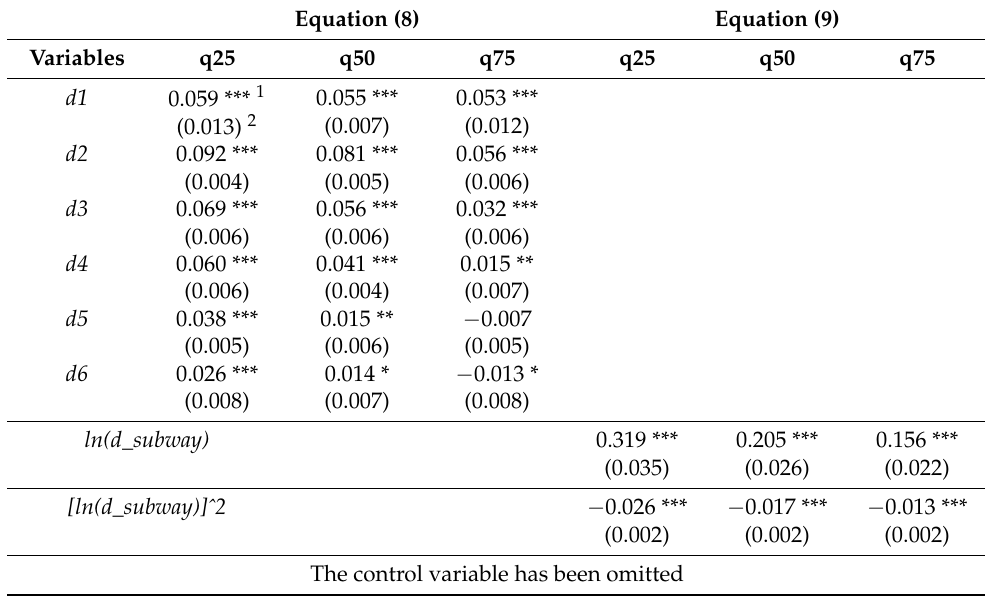
Figure 3. Changes of coefficients of ln(d_subway) , [ln(d_subway)]^2 in different quantile regression results in Equation (9). Table 4. Quantile regression results.